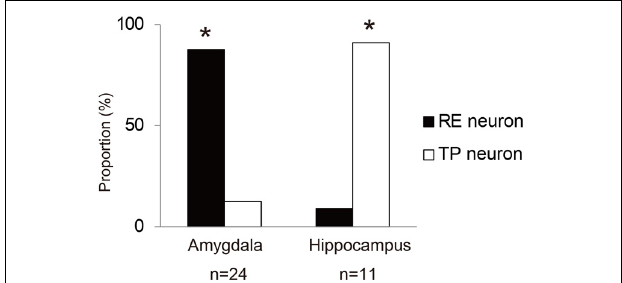
FIGURE 5 | Proportions of RE neurons and TP neurons in the amygdala and hippocampus. The asterisks indicate a significant difference between RE and TP